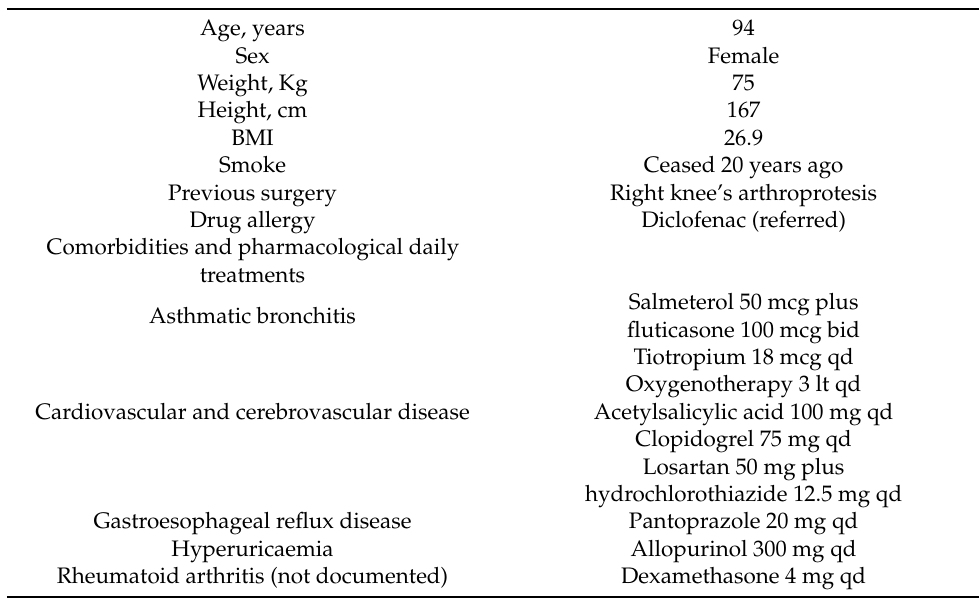
Table 1. Clinical characteristics of the